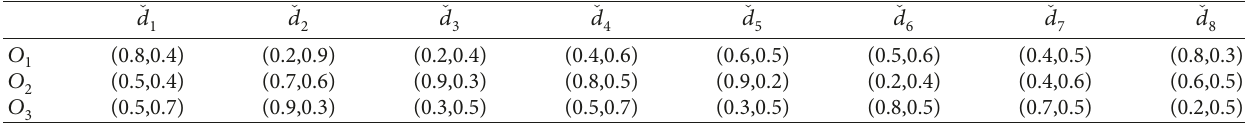
Table 4: PFHS decision matrix for H 4 .